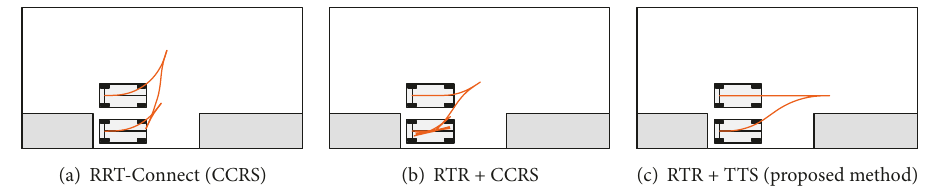
Figure 13: Path planning for parallel parking.